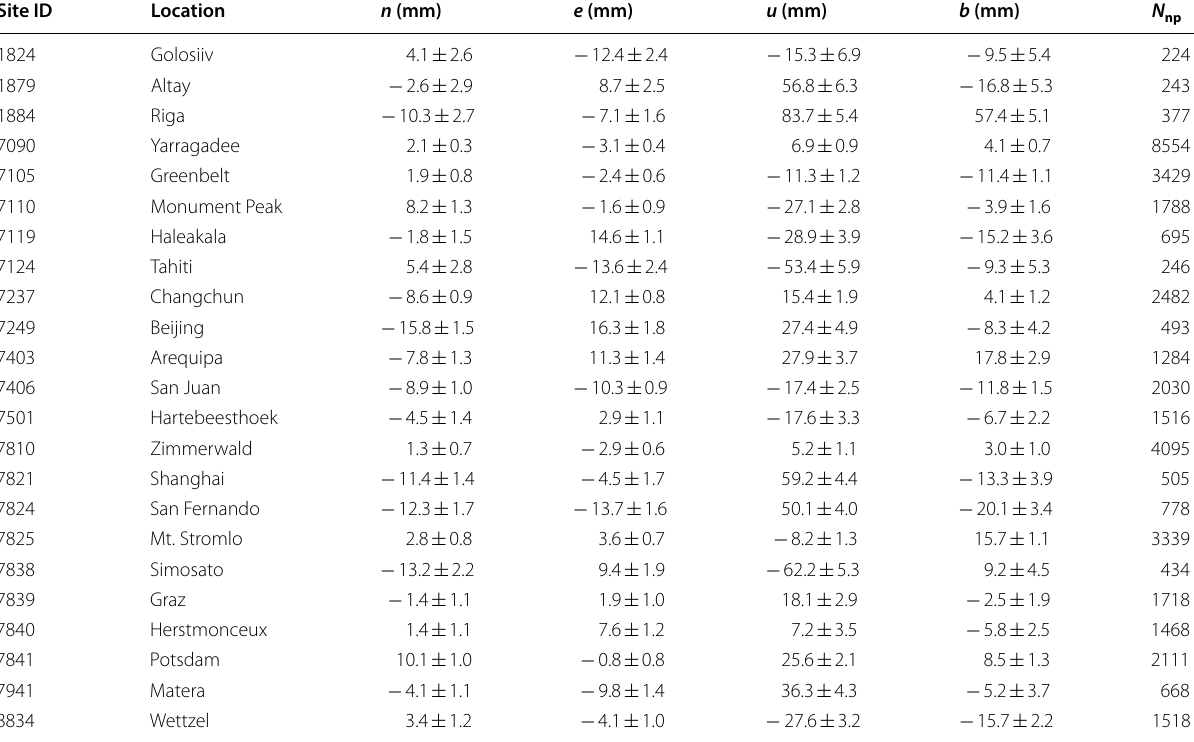
All values are on the basis of January–December 2012 and refer to the mean epoch 2012.5. In addition, the number of normal points ( N np ) is given and no timing bias corrections were